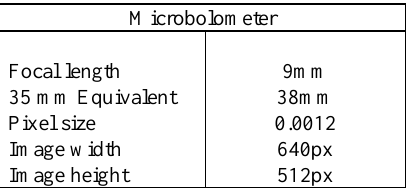
Table 4 . RGB camera parameters